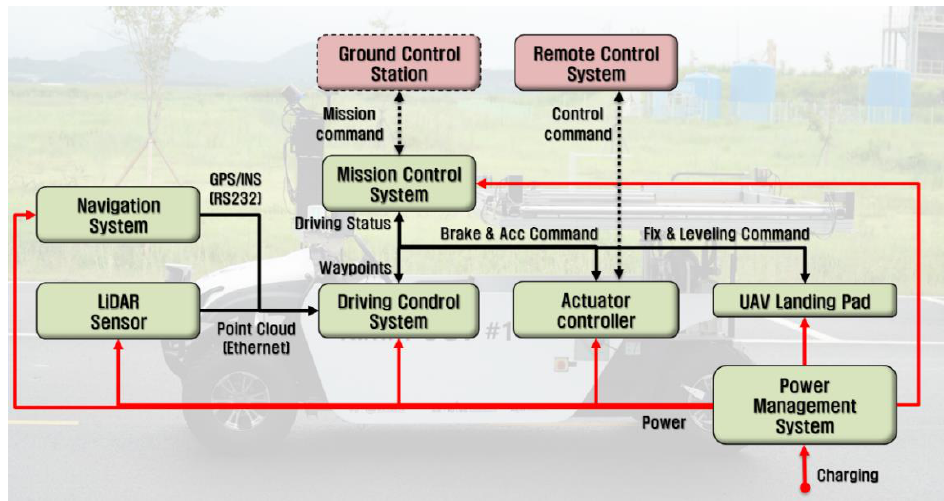
Figure 2. Block diagram of UGV system.